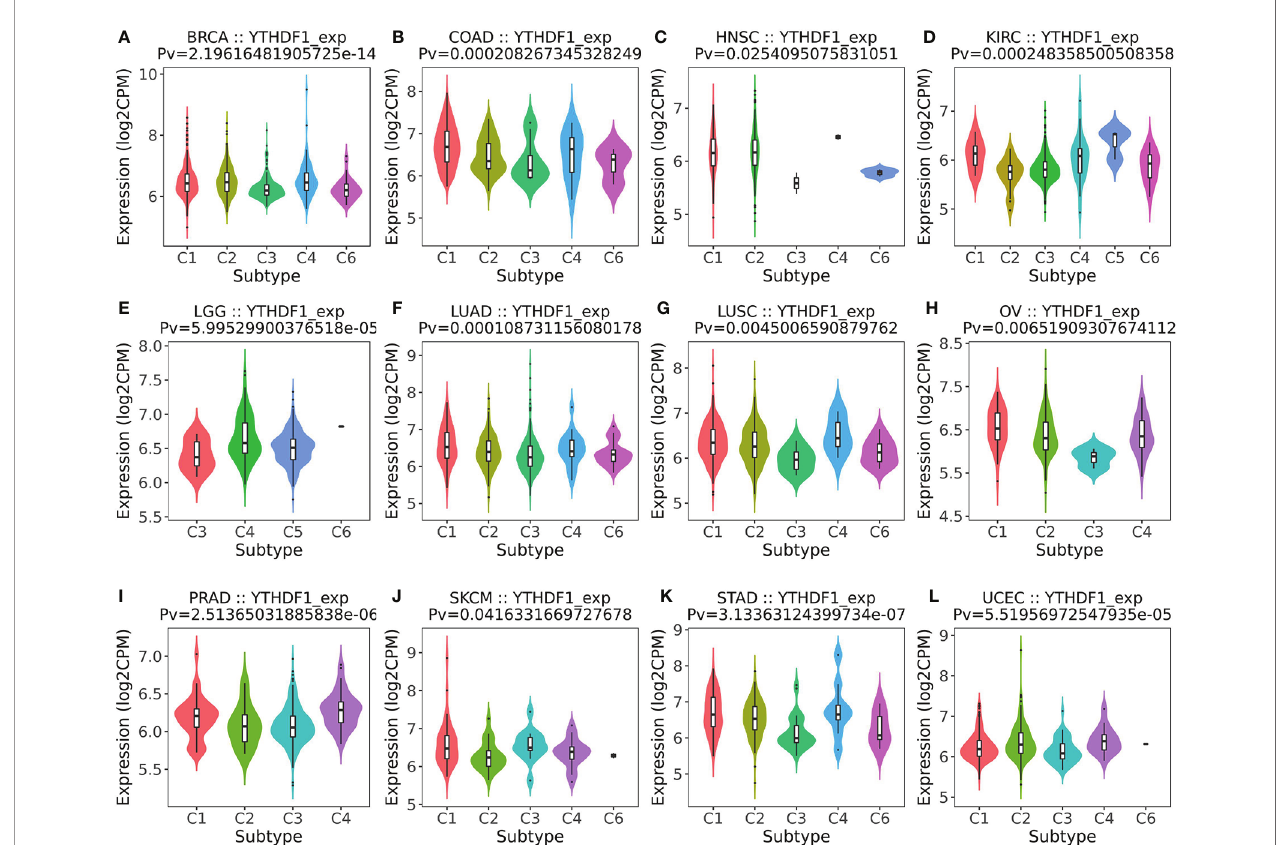
FIGURE 3 | The relationship between YTHDF1 expression and pan-cancer immune subtypes. (A) in BRCA, (B) in COAD, (C) in HNSC, (D) in KIRC, (E) in LGG, (F) in LUAD, (G) in LUSC, (H) in OV, (I) in PRAD, (J) in SKCM, (K) in STAD, (L) in